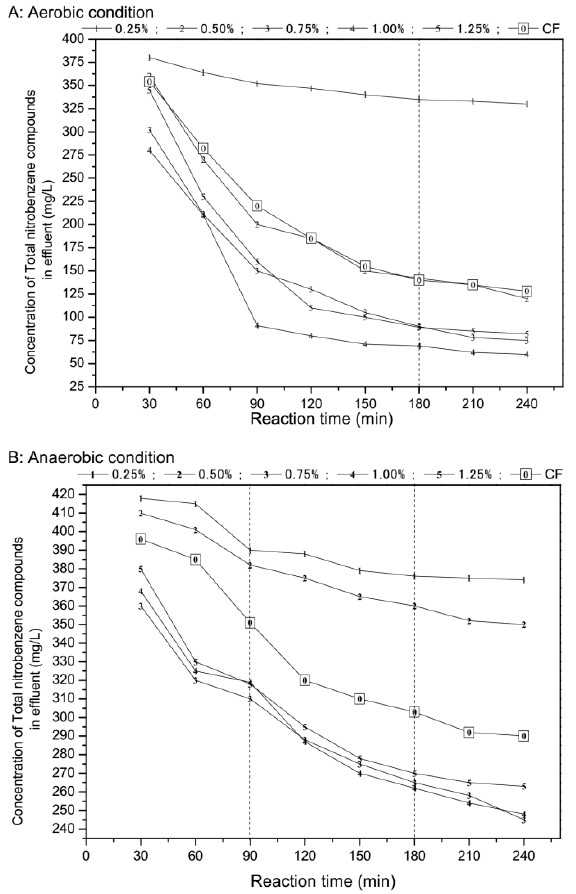
Figure 3. Effect of CCF and CF (Carbon Fe Catalyst) performed at aerobic/anaerobic